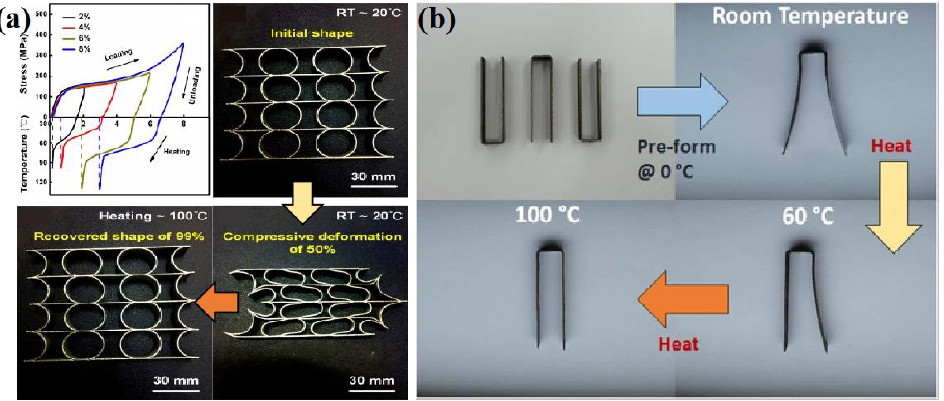
Figure 9. ( a ) Multilevel shape memory recovery behavior and ( b ) shape memory recovery process of Ni-Ti components formed by SLM [19,27].